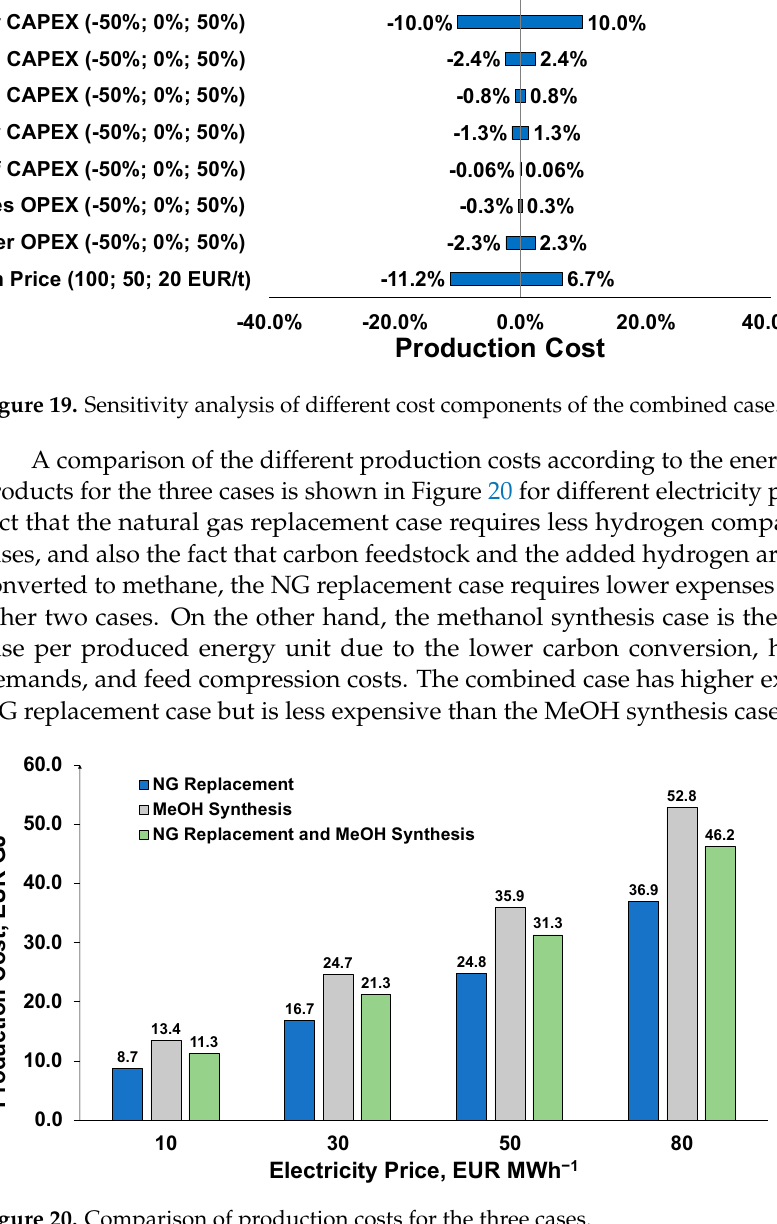
Figure 20. Comparison of production costs for the three cases.